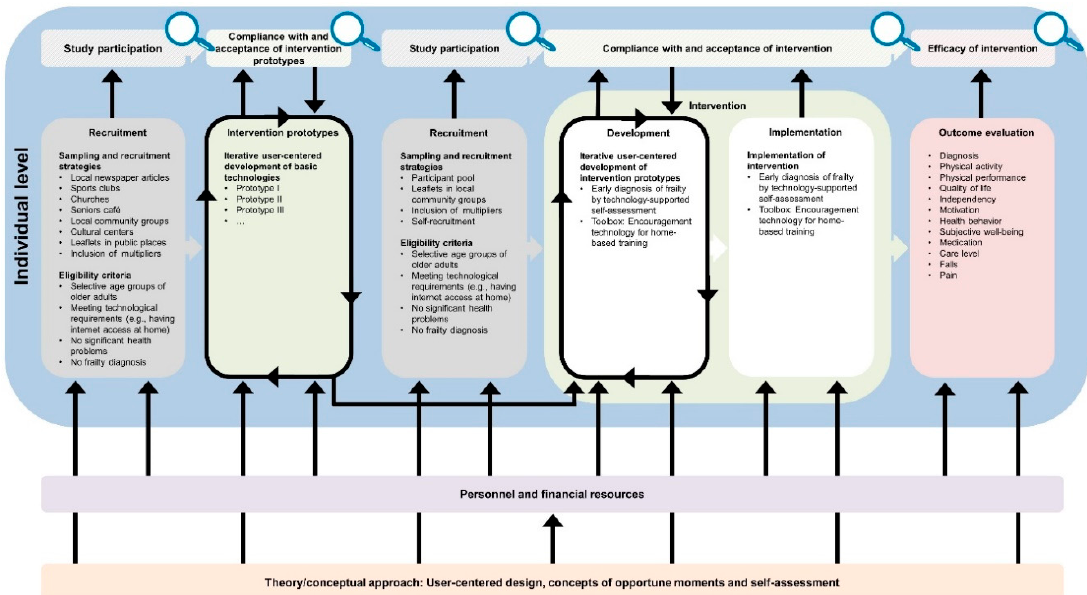
Figure 3. Specific equity-focused logic model for the individual-level technology-based individualized intervention aimed at encouraging physical activity and preventing functional decline in older adults implemented in TECHNOLOGY.